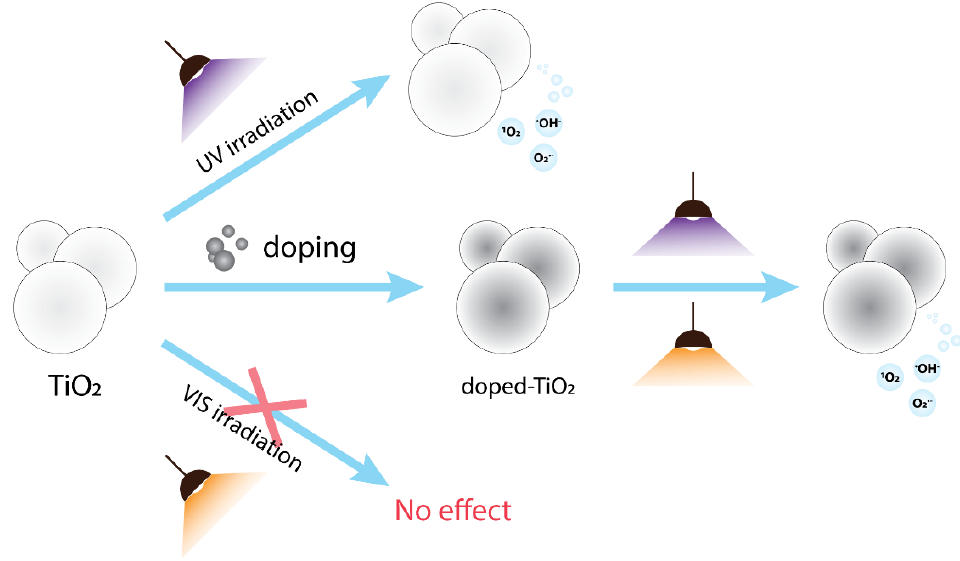
Appl. Sci. 2021 , 11 , x FOR PEER REVIEW Figure 6. Graphical explanation of TiO 2 doping for water remediation. Figure 6. Graphical explanation of TiO 2 doping for water remediation.